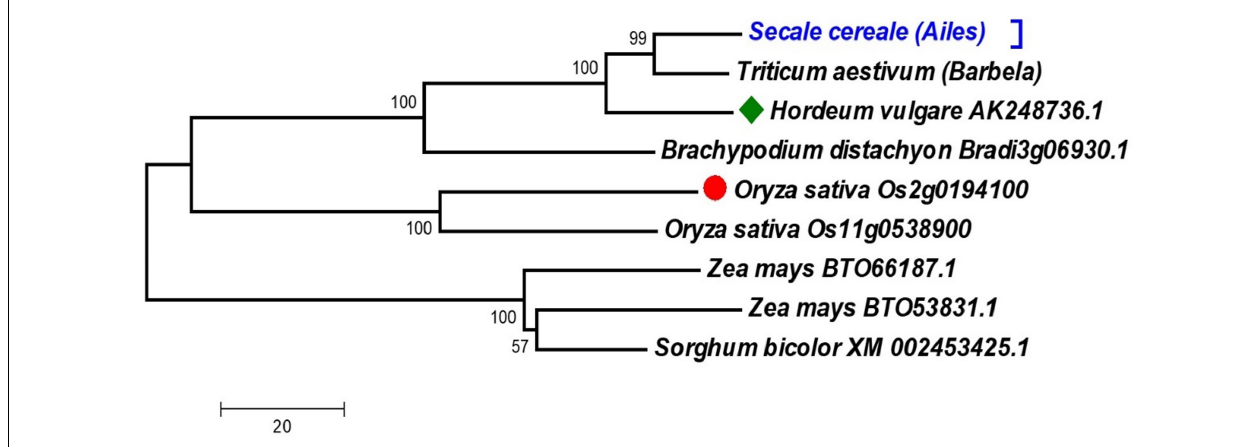
FIGURE 2 | The dendrogram was obtained from the sequences of cDNAs of ScCS4 gene and CS genes of seven different Poaceae species. The studied sequences of cDNAs and proteins were extracted from NCBI and Phytozome. Bootstraps with 10,000 replicates were calculated to test the robustness of the dendrogram. The red circle indicates the starting rice sequence and the green diamond indicates the barley sequence. The ScCS4 sequence obtained has been indicated with light blue text.